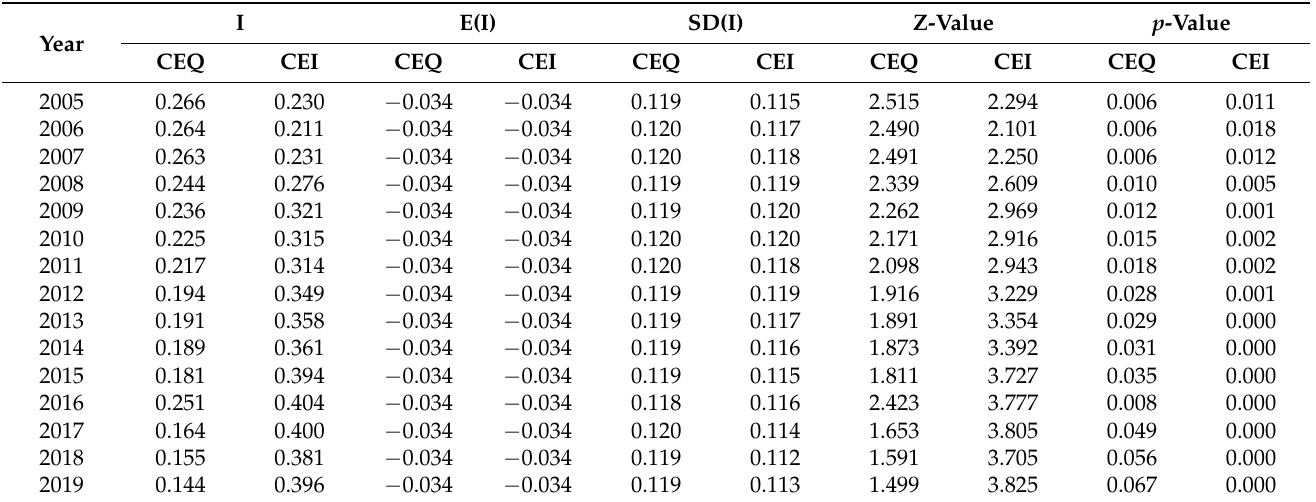
Table 6. Moran’s I index of contribution rate of CEQ and CEI from 2005 to 2019.